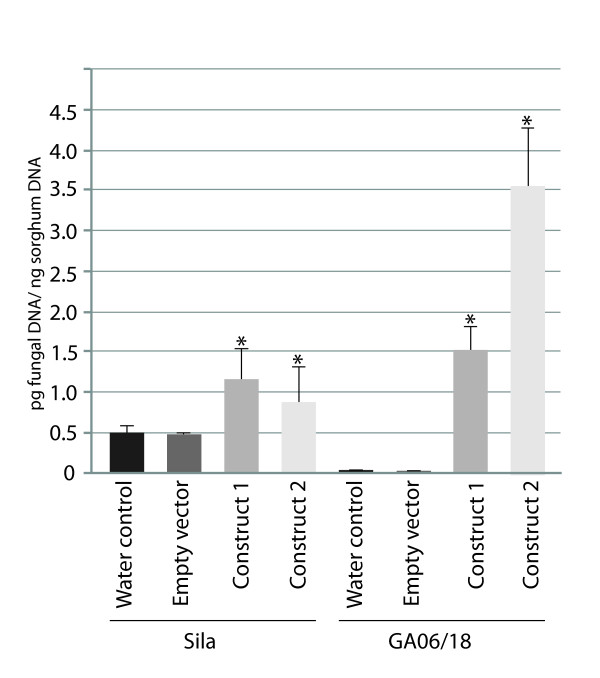
Real-time qPCR assessment of S. turcica DNA on resistant GA06/18 and susceptible Sila leaf samples, 7 dpi with S. turcica, pretreated either with water, empty vector, or VIGS construct 1 and 2. Error bars indicate standard deviation between three biological replications. * Indicates a significant increase (P < 0.05) in fungal DNA compared to control levels.